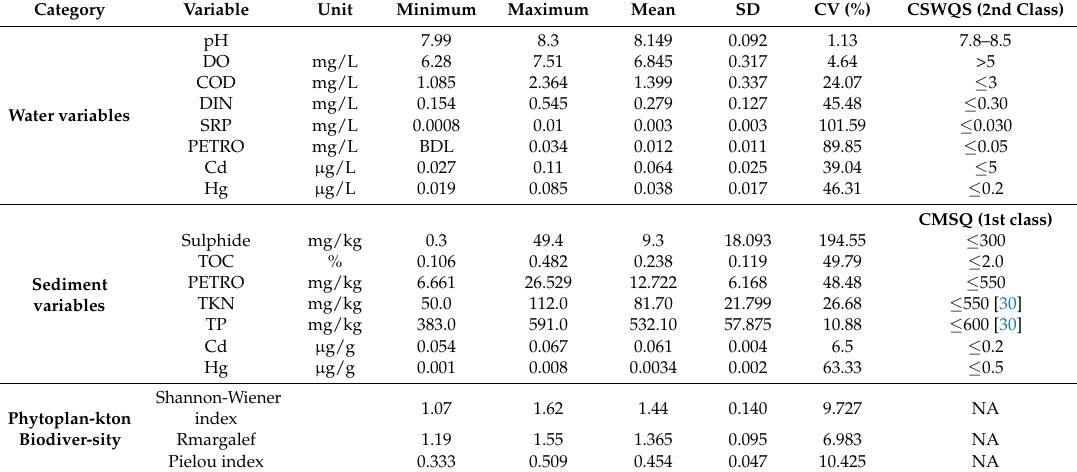
Table 2. Descriptive statistics of measured variables of water and sediment samples post-Phase I (September